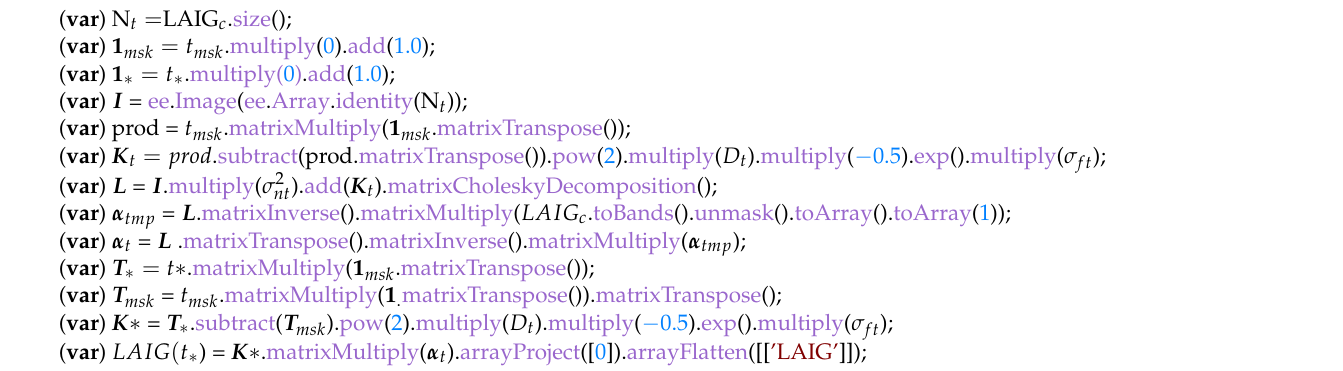
Table 6. Lines of pseudo-code of GPR gap-filling core implementation in GEE with mathematical notation for variable easy